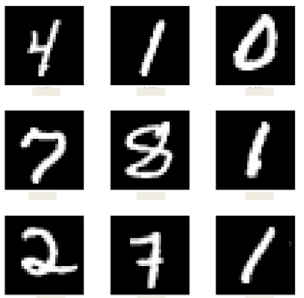
Figure 1. Examples from the MNIST